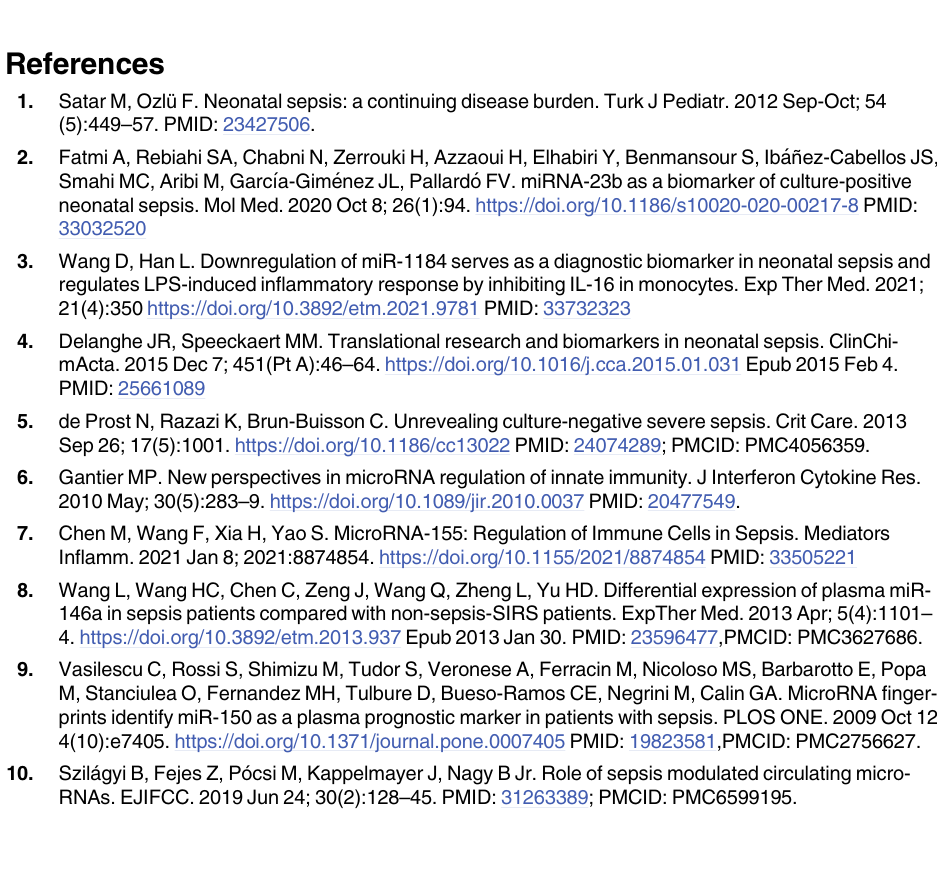
S1 Fig. ROC curve analysis of serum miR-34a-5p, miR-199a-3p and IT ratio for differenti- ating neonates with sepsis from healthy ones. S1 Table. miR-34a-5p and miR-199a-3p fold change in neonates with sepsis. S2 Table. Multivariable logistic regression